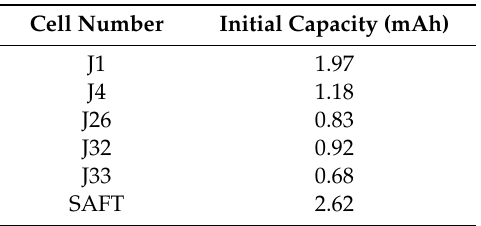
Table 1. Initial capacity of